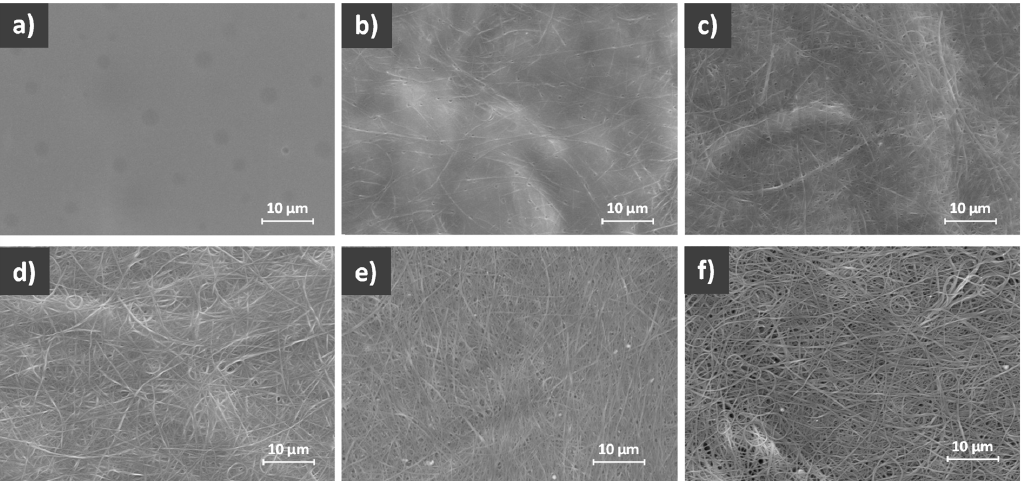
Figure 4. Scanning electron microscopy (SEM) images of the P(TBT-Pt)/SWCNTs composite films with different SWCNT loading, ( a ) 0%, ( b ) 10%, ( c ) 30%, ( d ) 50%, ( e ) 70%, ( f ) 90%.